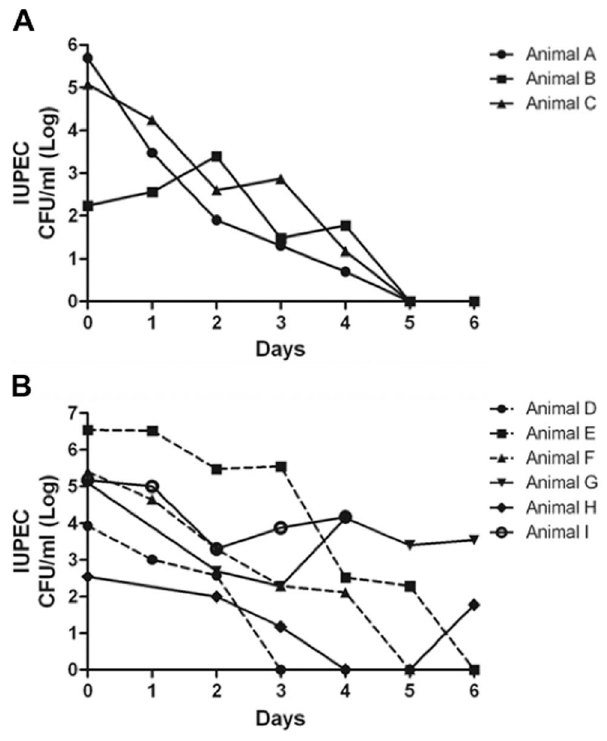
Figure 5. Invivo antimicrobial activity of chitosan microparti- cles. CM reduces number of intrauterine pathogenic E. coli (IUPEC) in the uterus. Dairy cattle with uterine disease were treated with either 0.2% CM (A), n=8, via intrauterine fusion or antibiotic Ceftiofur hydrochloride (B), n=10, systemically for five days. Swabs were collected from uterus for a seven days and IUPEC was enumerated on E. coli selective media CHROMagar. Plates were incubated at 37 u C overnight, and the numbers of CFU/ml were counted. Numbers of IUPEC in the uterus are presented from individual animals shed this pathogen on Day 0. Solid lines represent animals without IUPEC after treatment; dashed lines represent animals with IUPEC after treatment.